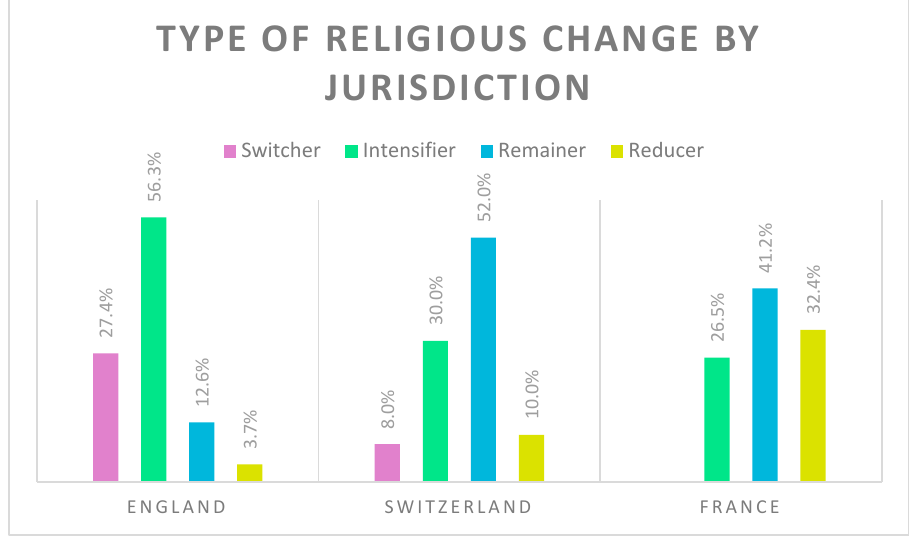
Figure 5. Type of religious change in prison in different jurisdictions.